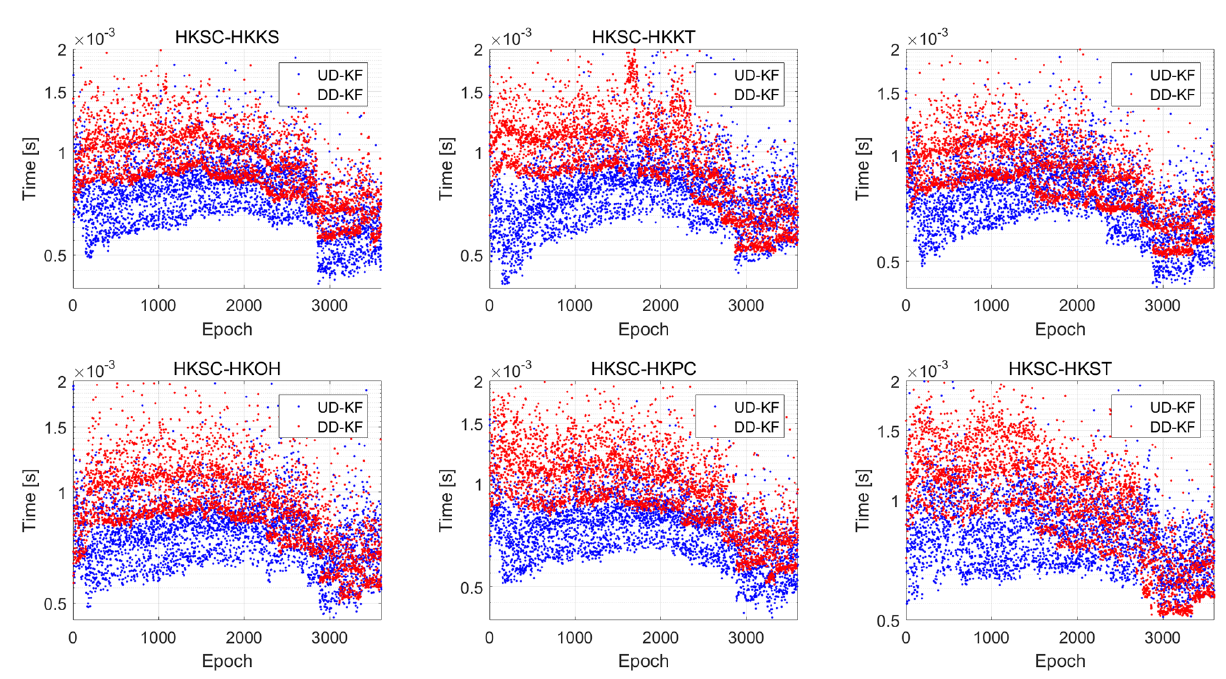
Figure 10. Fix computation efficiency.